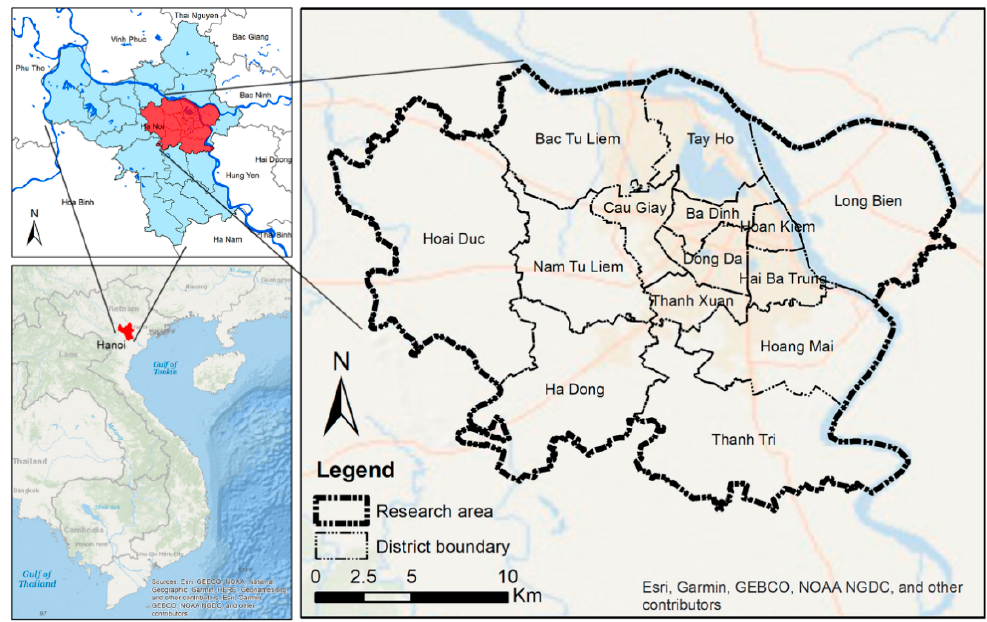
Figure 1. Location of the study area.